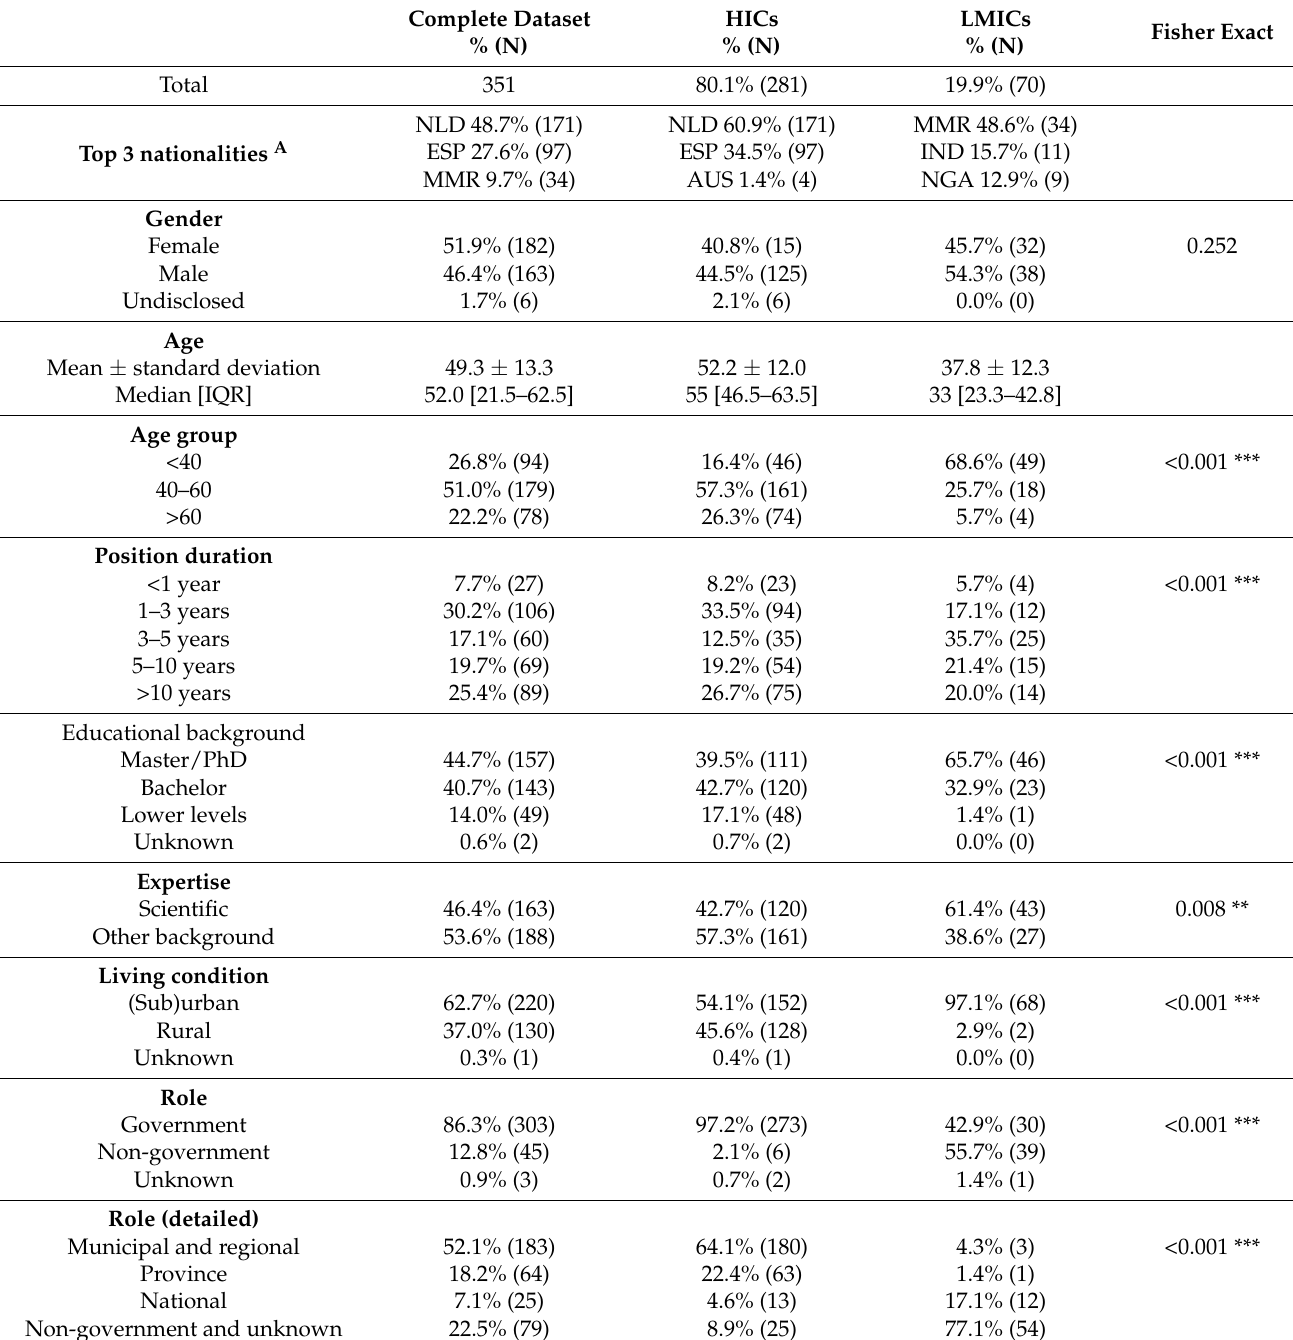
Table 1. Sociodemographic description of all participants, stratified for low- and middle-income (LMICs) and high-income countries (HICs). Differences between subsets were analyzed by Fisher’s exact test. Significance: *** p < 0.001, and ** p <